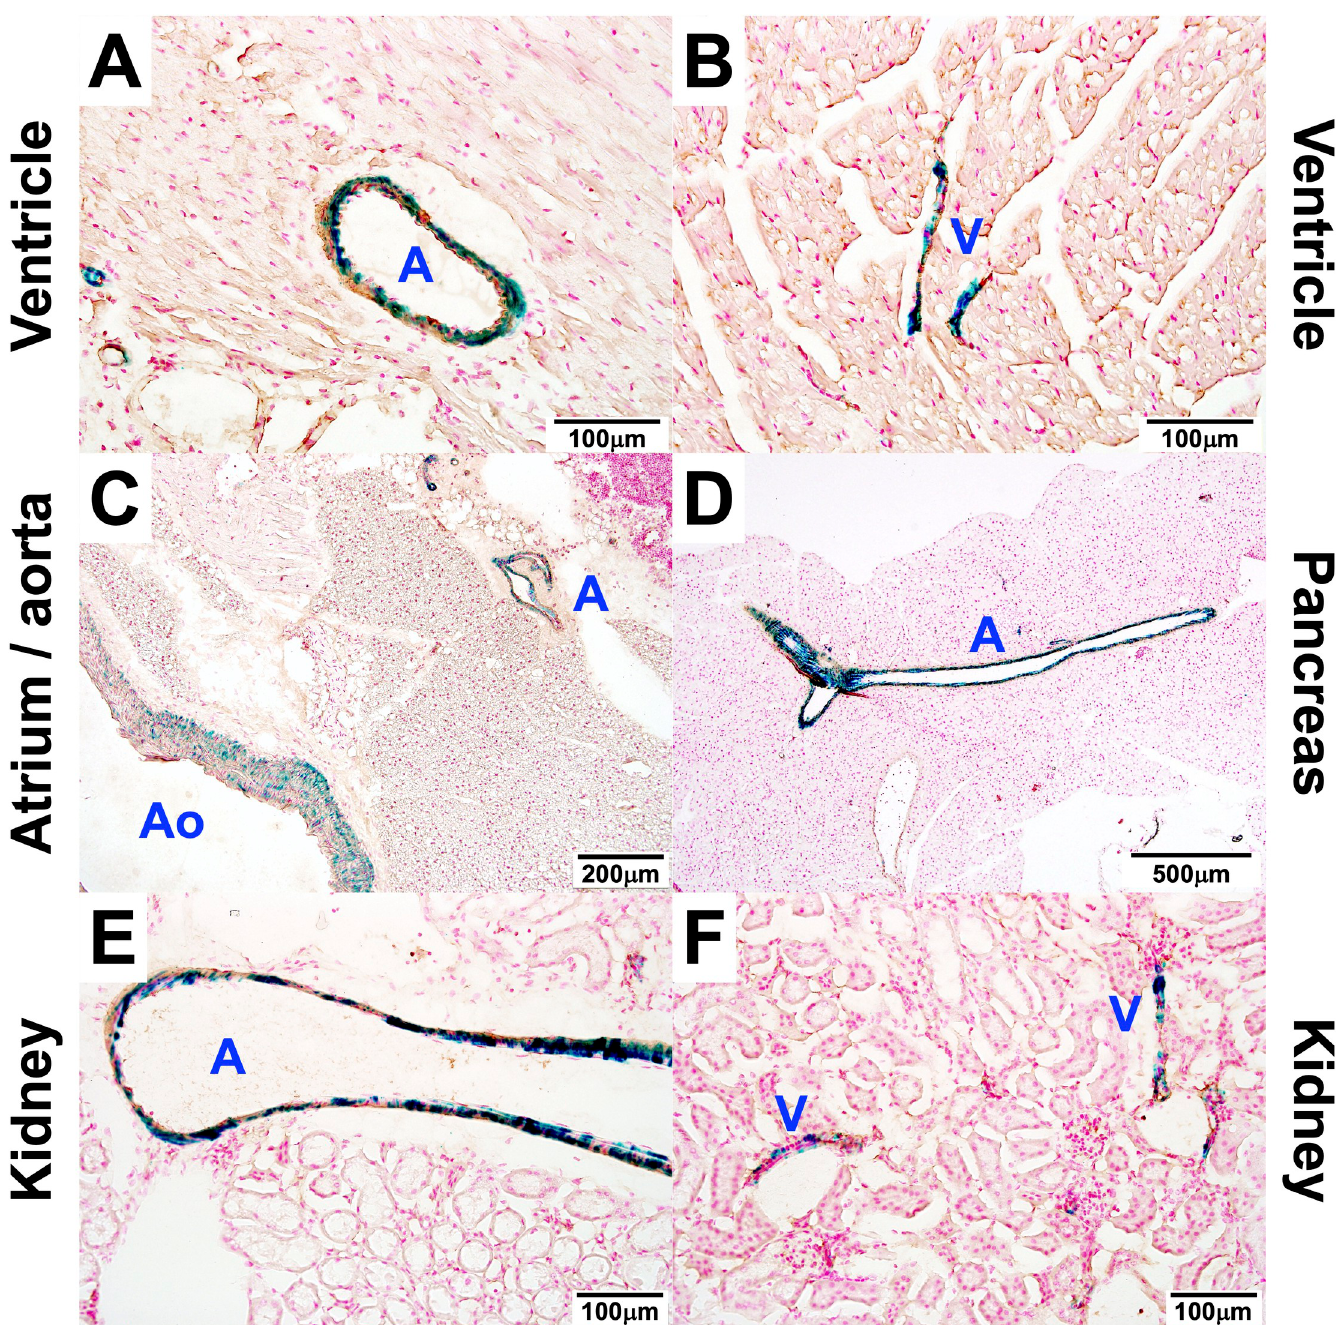
Fig 6. MYL9 is expressed in the smooth muscle of blood vessels. Histological sections of the (A, B) ventricle of the heart, © aorta and atrium of the heart, (D) pancreas and (E, F) kidney from a representative Myl9 -/+ mouse were stained with X-gal to detect Myl9 promoter activity and an anti- α -SMA antibody (brown stain) to identify smooth muscle. A = artery; Ao = aorta; V =